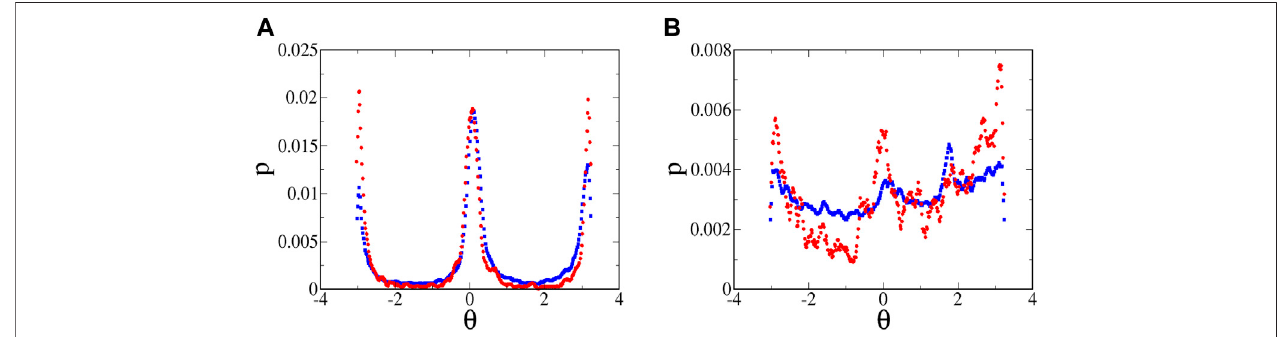
FIGURE11| Probabilitydistributionofswimminganglesformicrobesat ~ y (cid:1) 0. (A) Euglena, A =1.8s − 1 (blue), A =3.6s − 1 (red). (B) Tetraselmis, A =1.8s − 1 (blue), A = 3.6 s − 1 (red).